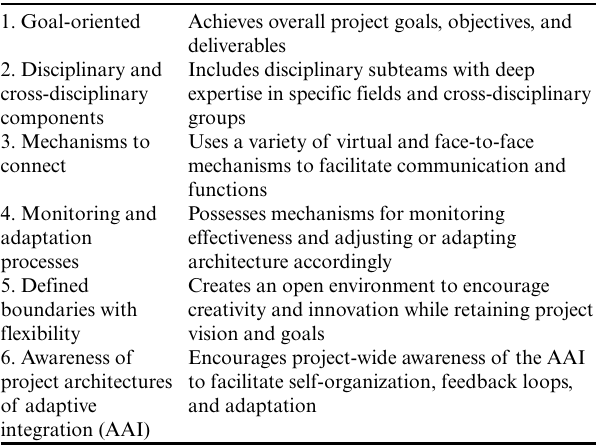
Table 1 . Key attributes of architectures of adaptive